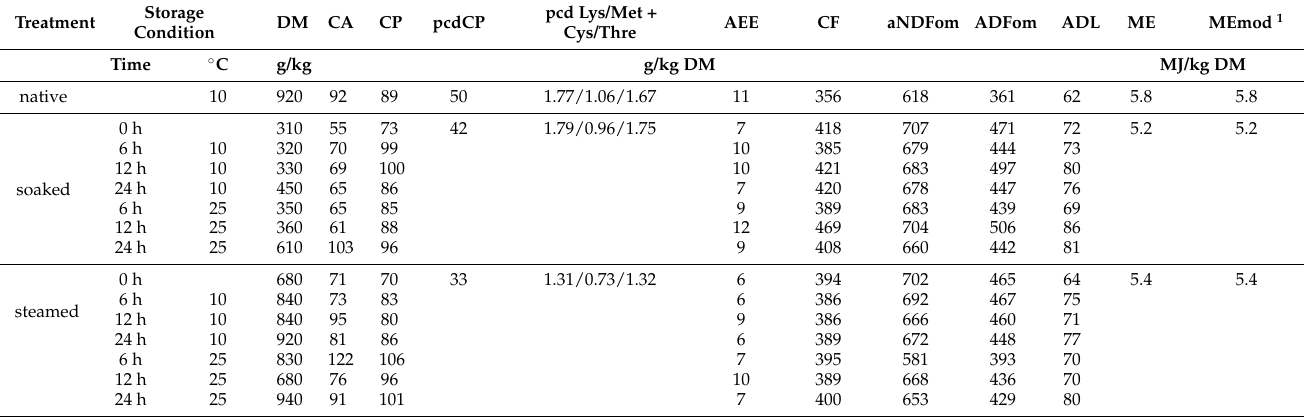
Table 2. Proximate nutrients of the native and treated hay.